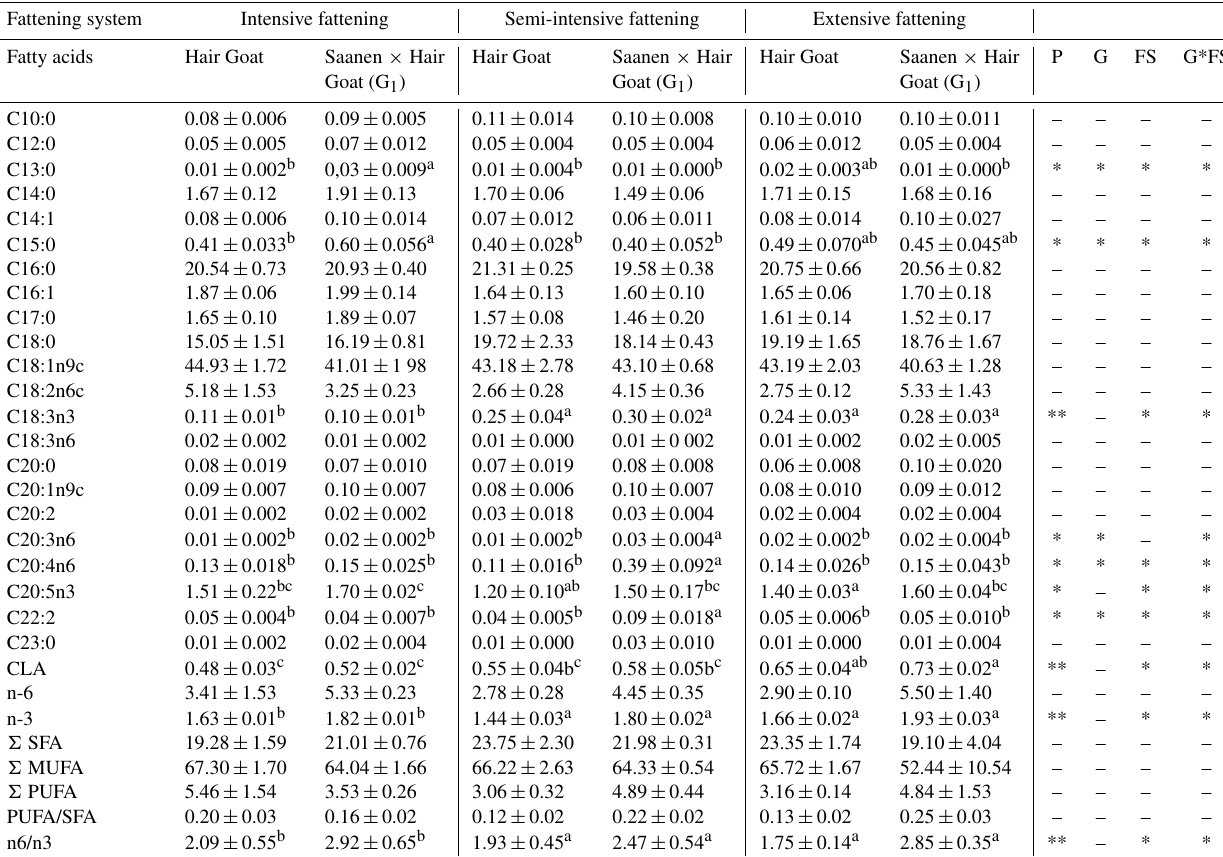
Table 4. Meat fatty acid composition of Hair Goat and Saanen × Hair Goat (G 1 ) crossbred kids (%). Fattening system Intensive fattening Semi-intensive fattening Extensive fattening Fatty